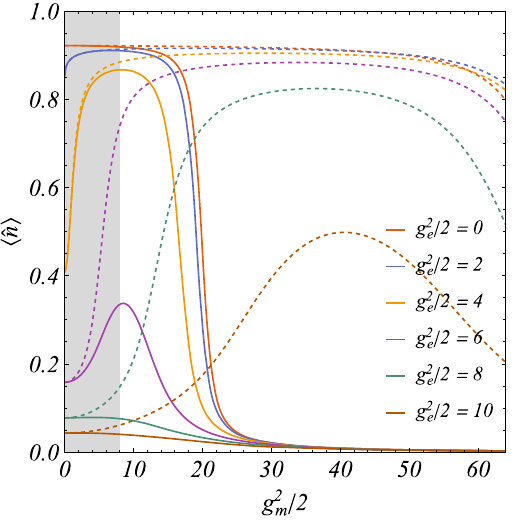
FIG. 19. Behavior of the particle density vs the magnetic coupling in the 2 × 2 system for m ¼ − 2 and different electric = 2 . The shaded gray area represents the region couplings g 2 e explored in Fig. 6. Solid lines are the S ¼ 1 results; dashed lines are the S ¼ 2 results.